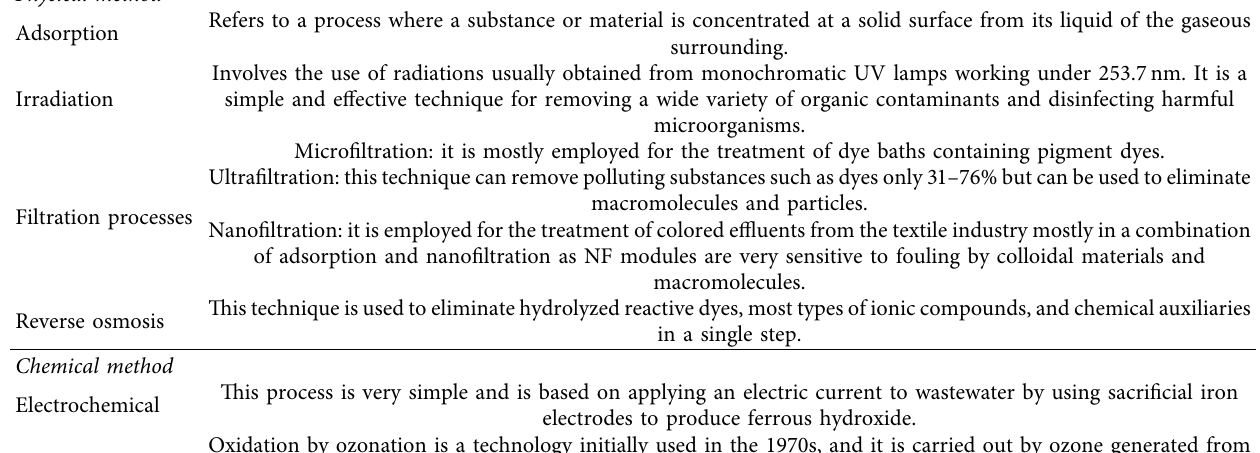
Table 2: Methods of synthetic dye biodegradation and decolorization [32, 41,